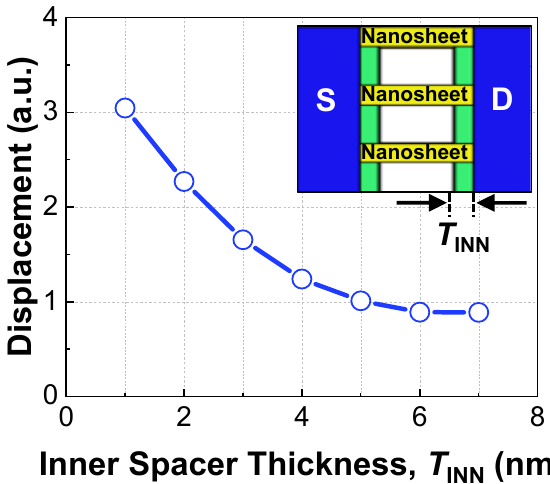
Figure 5. Extracted mechanical displacement with inner spacer thickness ( T INN ).